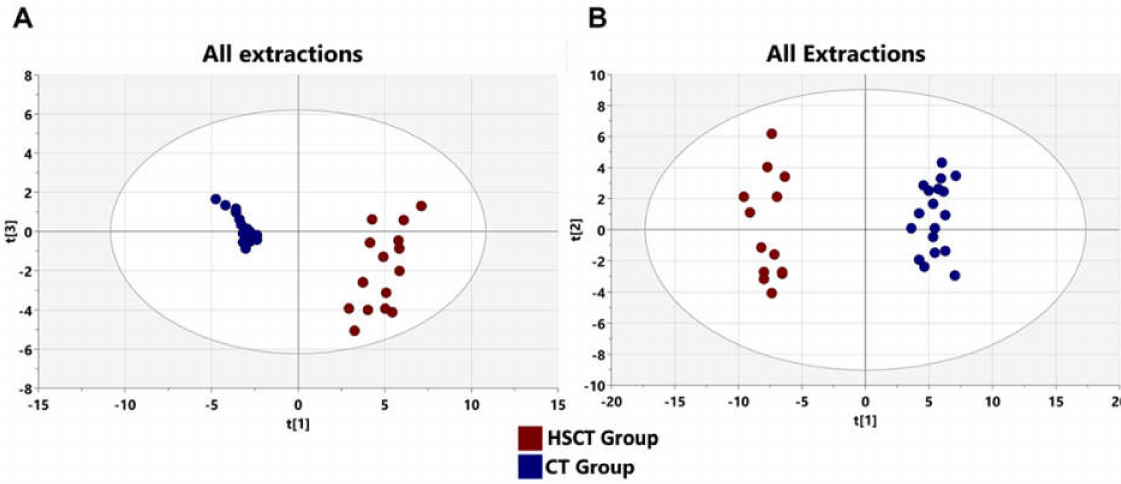
Figure 5. PCA and OPLS-DA score plots of the fecal metabolic profiles from the (allo-HSCT) and control (CT) groups. An overview of the data from the two extractions confirms that there are no outlying samples within a 95% confidence interval. ( A ) PCA score plot model with R 2 (X) = 0.632 and Q 2 = 0.557 values. Red circles represent allo-HSCT samples and blue circles represent CT samples. ( B ) Orthogonal partial least squares-discriminant analysis (OPLS-DA) score plot model showing separation based on all extraction methods with R 2 (X) = 0.482, R 2 (Y) = 0.981, Q 2 = 0.909 and cross validated analysis of variance (CV-ANOVA) p = 3.956 × 10 − 12 values. Blue circles represent healthy control samples and red circles represent allo-HSCT samples.